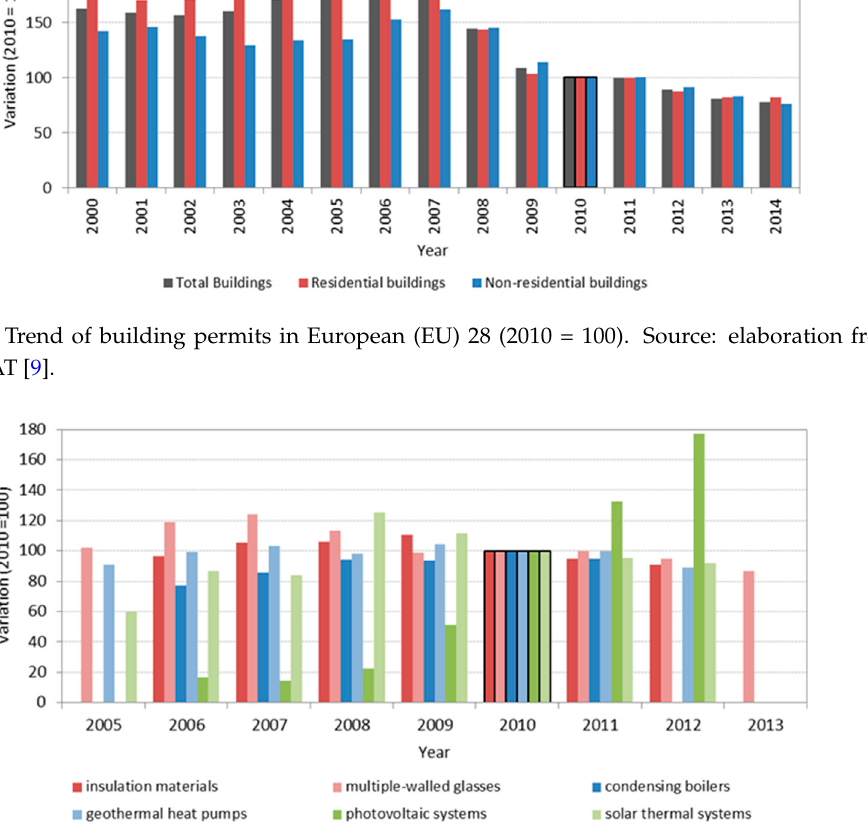
Figure 2. Trend of sales related to low-energy buildings in Europe (2010 = 100). Source: elaboration from Zebra 2020 database [10].